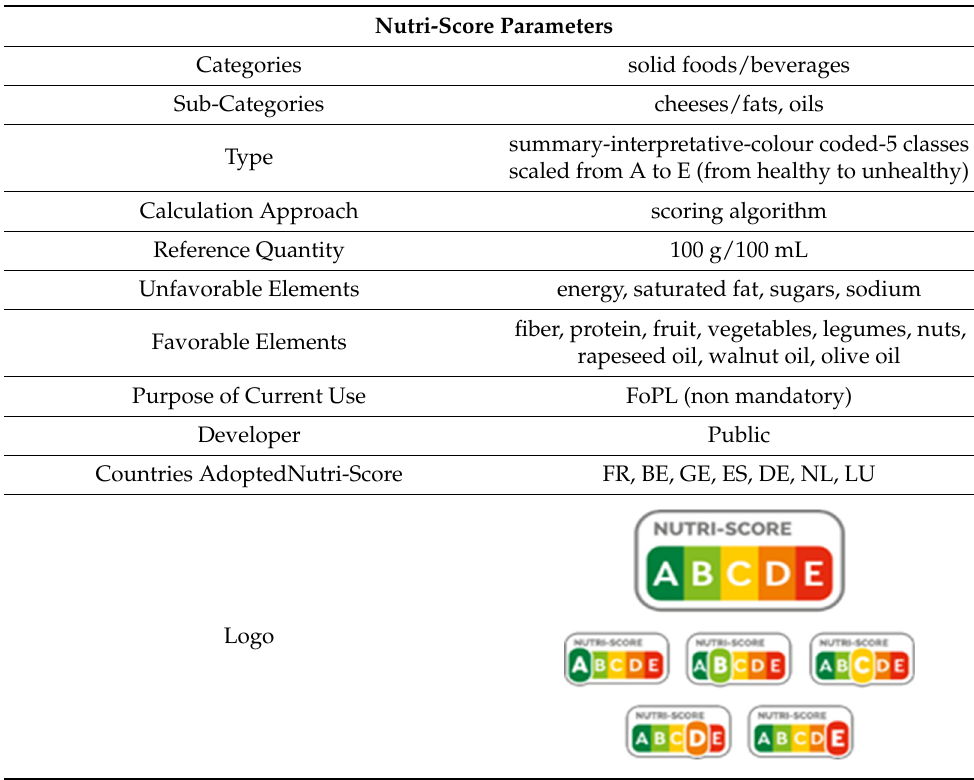
Table 1. Presentation of the Nutri-Score Front of Pack (FoP) label scheme parameters.